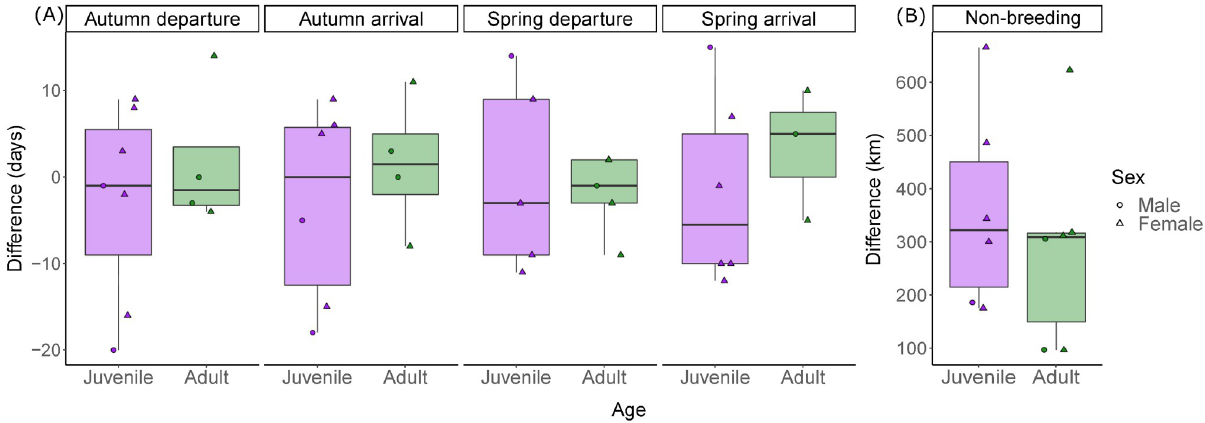
Fig 4. Intra-individual variation in (a) migration timing and (b) distance between non-breeding location for adult and juvenile Cyprus wheatears. Differences are between two consecutive years from light-level geolocation data. Timing differences (a) show the direction of the difference, i.e. whether the difference is earlier or later between year one and